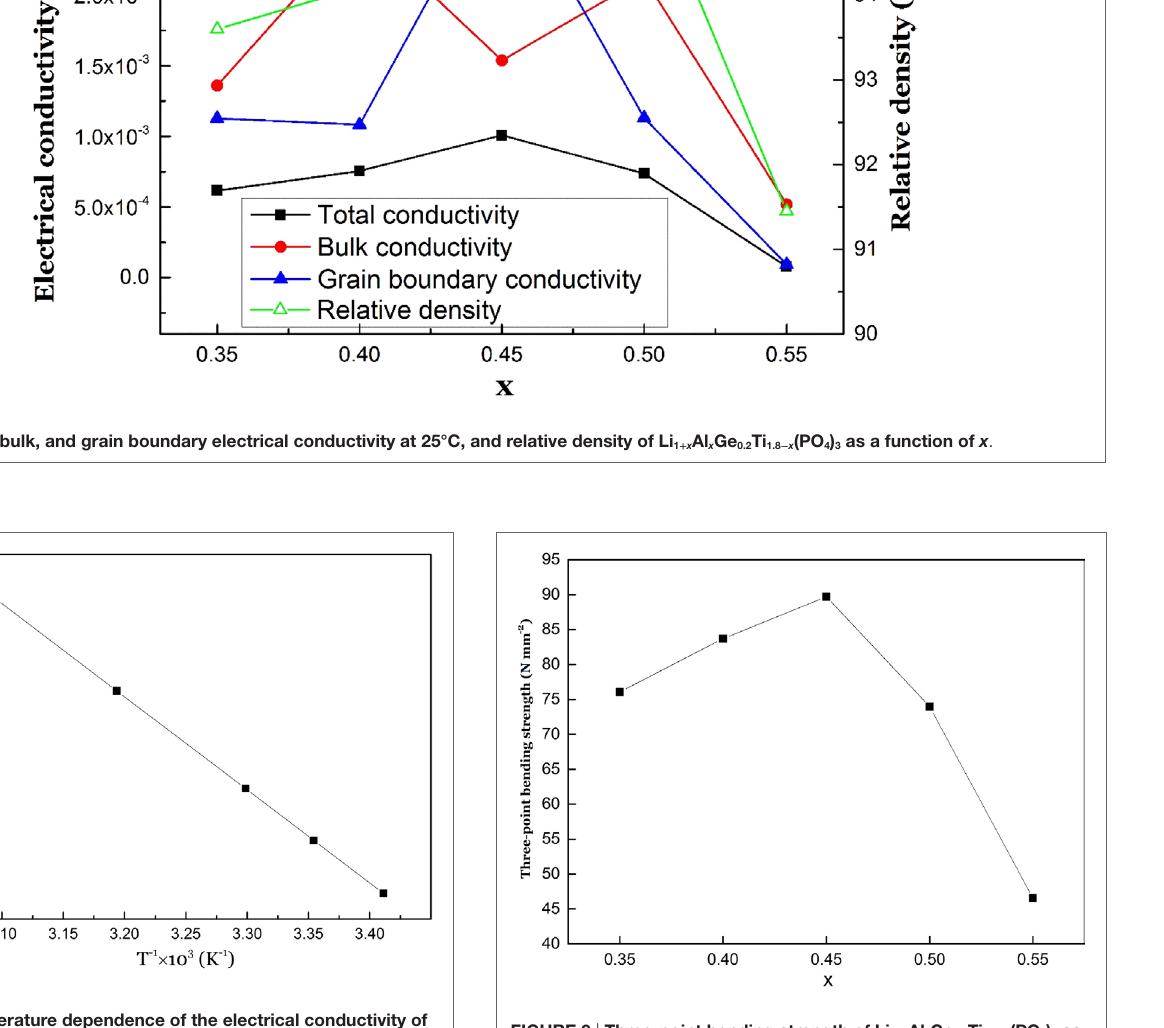
FigUre 9 | Three-point bending strength of li 1 + x al x ge 0.2 Ti 1.8 − x (PO 4 ) 3 as a function of x .